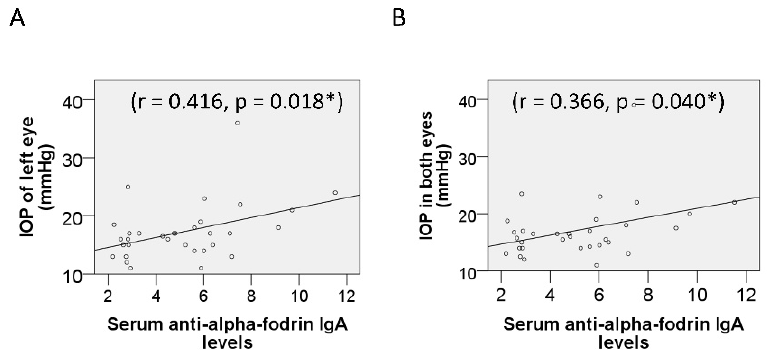
Figure 1. Correlation between intraocular pressure (IOP) and serum markers. The serum anti- α - fodrin IgA antibody level showed correlation with IOP in the left eye ( A ) and with mean IOP in both eyes ( B ). * Statistically significant.